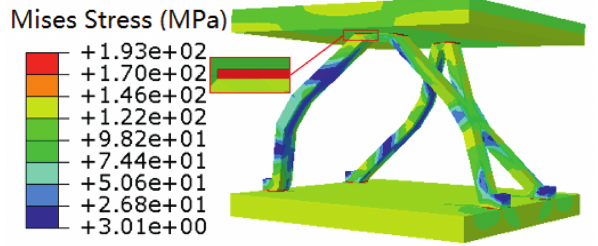
Figure 6: Contour of the initial total Mises stress.